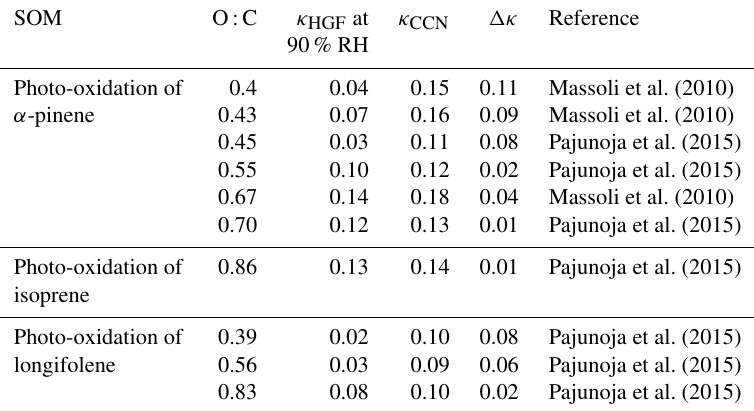
Table 4. Literature data of measured average O:C, κ HGF , κ CCN , and the difference between κ HGF and κ CCN , denoted as (cid:49)κ , of SOMs. The average O:C values are based on measurements from the individual studies referenced here. The experimental conditions for the studies reported in Table 4 were not necessarily similar to the experimental conditions for the studies reported in Table 3, even if the same precursor volatile organic compound was